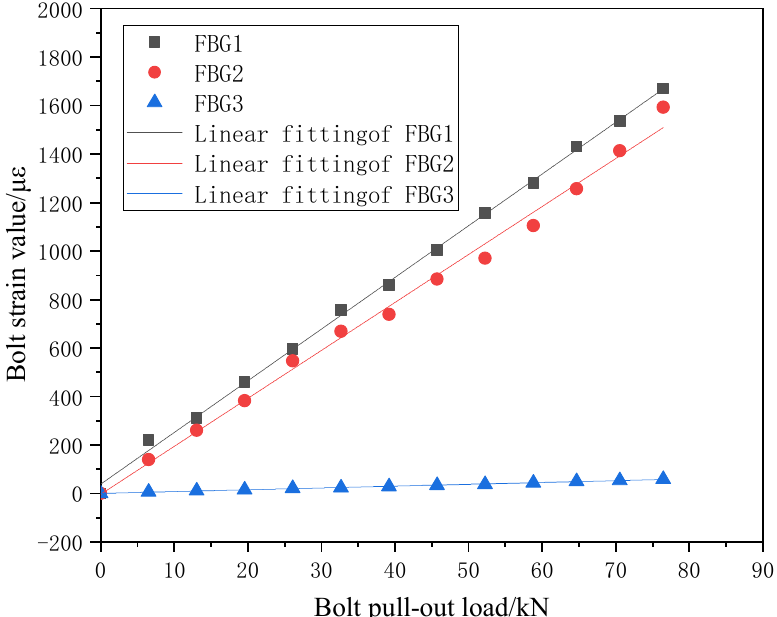
Figure 8. Variation curve of bolt strain with pull-out load.